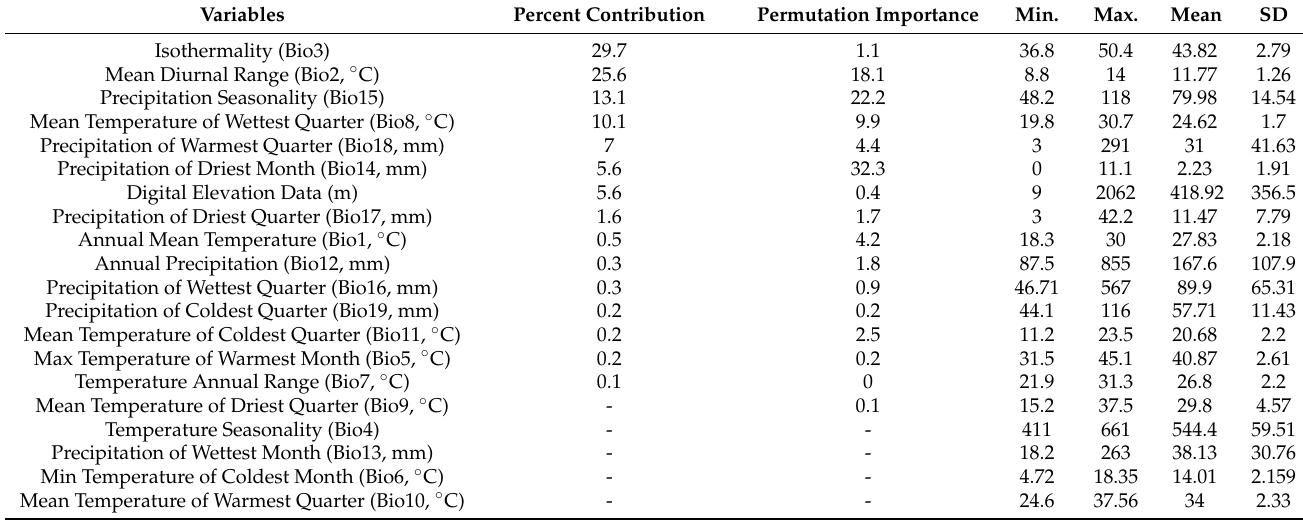
Table 1. The environmental variables considered in the 16SrII-D phytoplasma niche models and the average percent contributions of the environmental variables. The general statistics have been calculated with the help of occurrences ( n = 68). The bold variables are the most frequently contributed factors of the model.